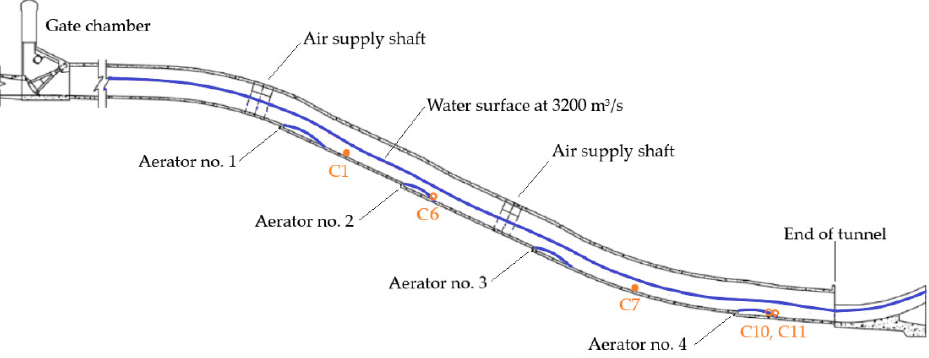
Figure 2. Aerators in Jinping ‐ I flood discharge tunnel with free ‐ surface flow (adapted from [15]). At the design reservoir water level, Q = 3200 m 3 /s at the 100% gate opening.